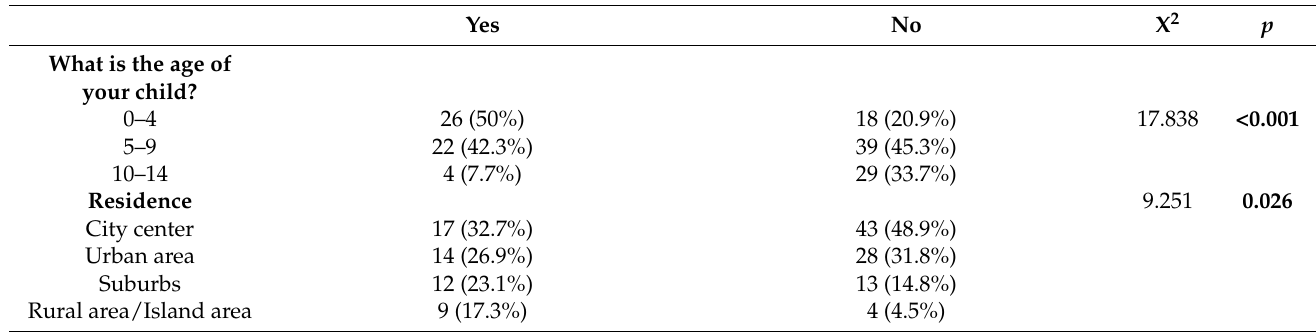
Table 4. Factors associated with children’s